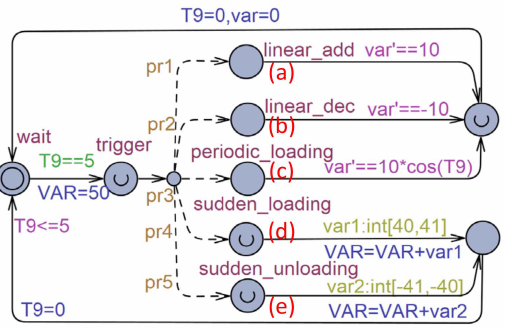
Figure 9. The NPTA-based modeling templates for Uncertainty